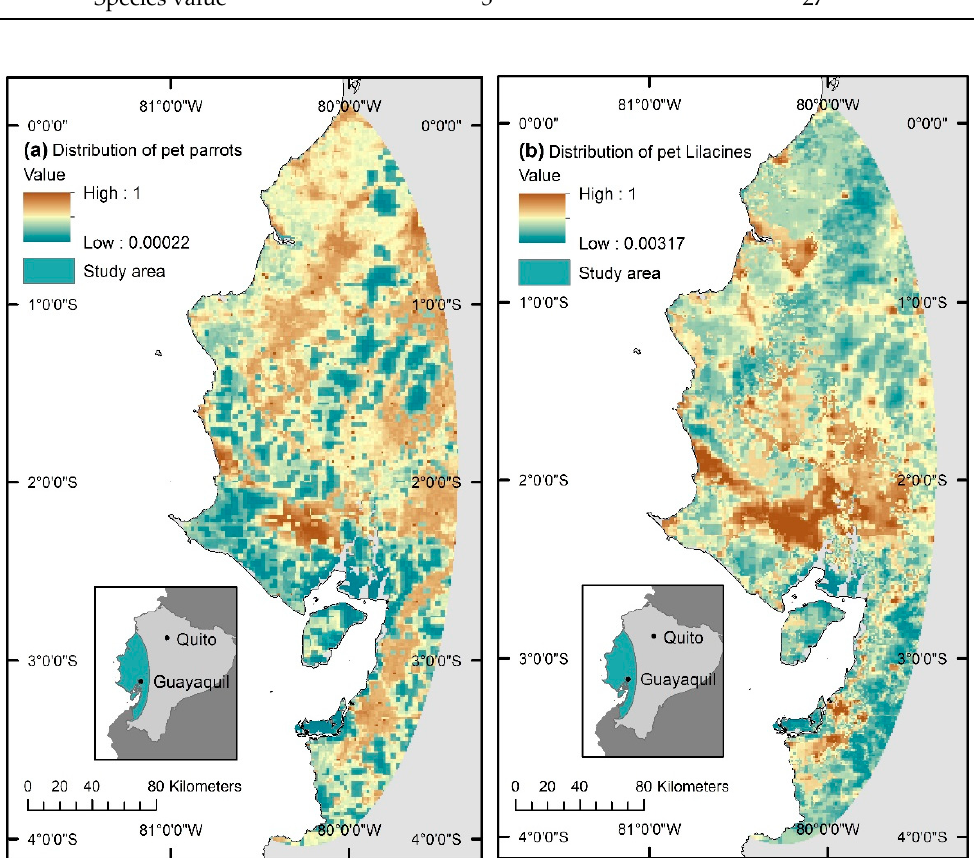
Figure 3. Model predictions showing the distribution of pet parrots ( a ) and pet Lilacines ( b ). Table 3. Permutation importance values for variables used to create models predicting the distri- bution of pet parrots and pet Lilacines in coastal Ecuador.